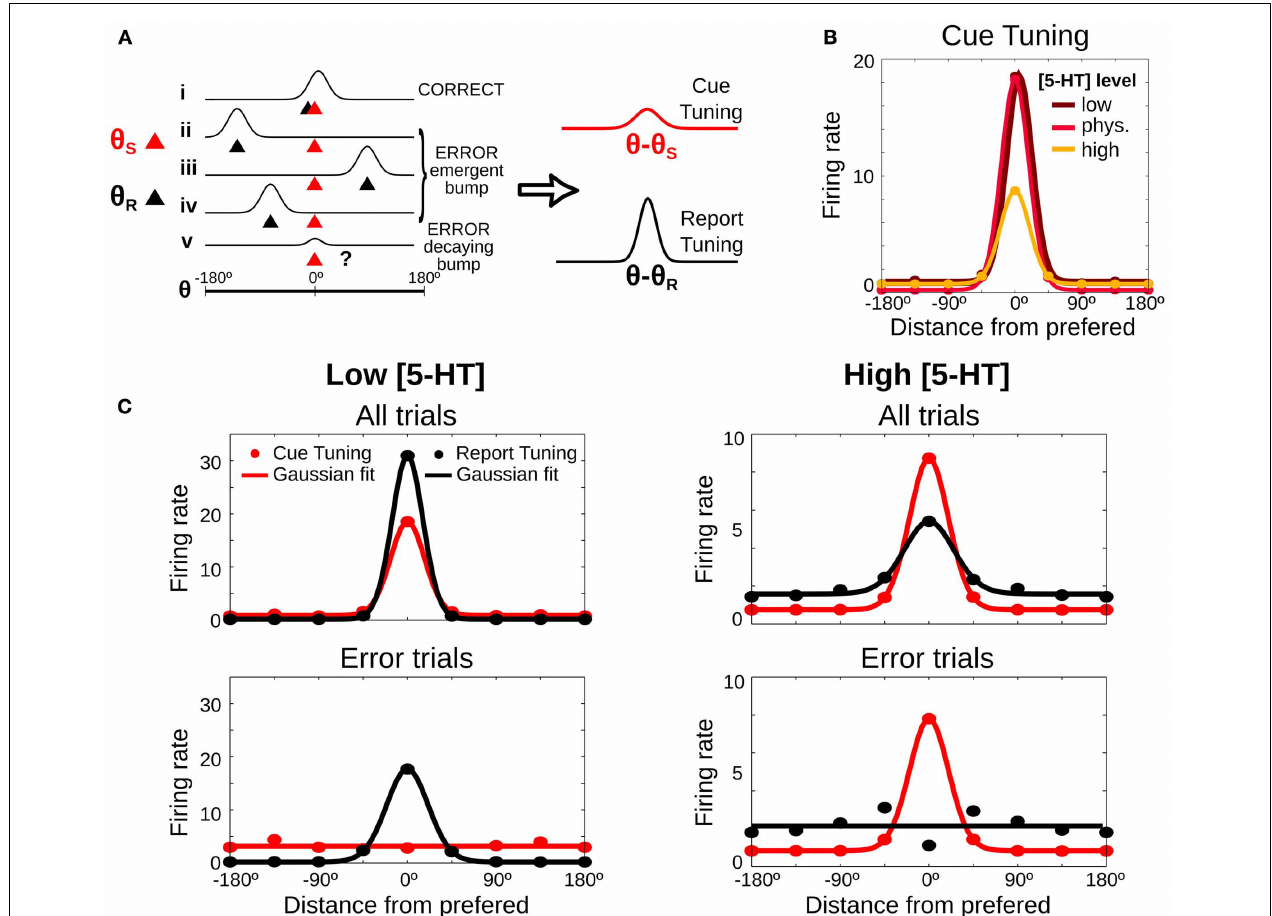
FIGURE 6 | Neuronal tuning curves change predictably depending on [5-HT] levels. (A) Scheme of 5 possible examples of neuronal firing rate during the delay period ( i–v ). The red triangle shows the location of the stimulus ( θ S ), the black triangle the report location calculated at the end of the delay period ( θ R ) and the classification of each trial is showed on the right, computed as in Figure 2 . Right, Tuning curves are computed by averaging firing rate, after aligning the trials to the stimulus location (red line, cue tuning ) or to the report location (black line, report tuning ). (B) Predicted delay cue tuning changes with 5-HT: low [5-HT] (dark red line) induces increases in